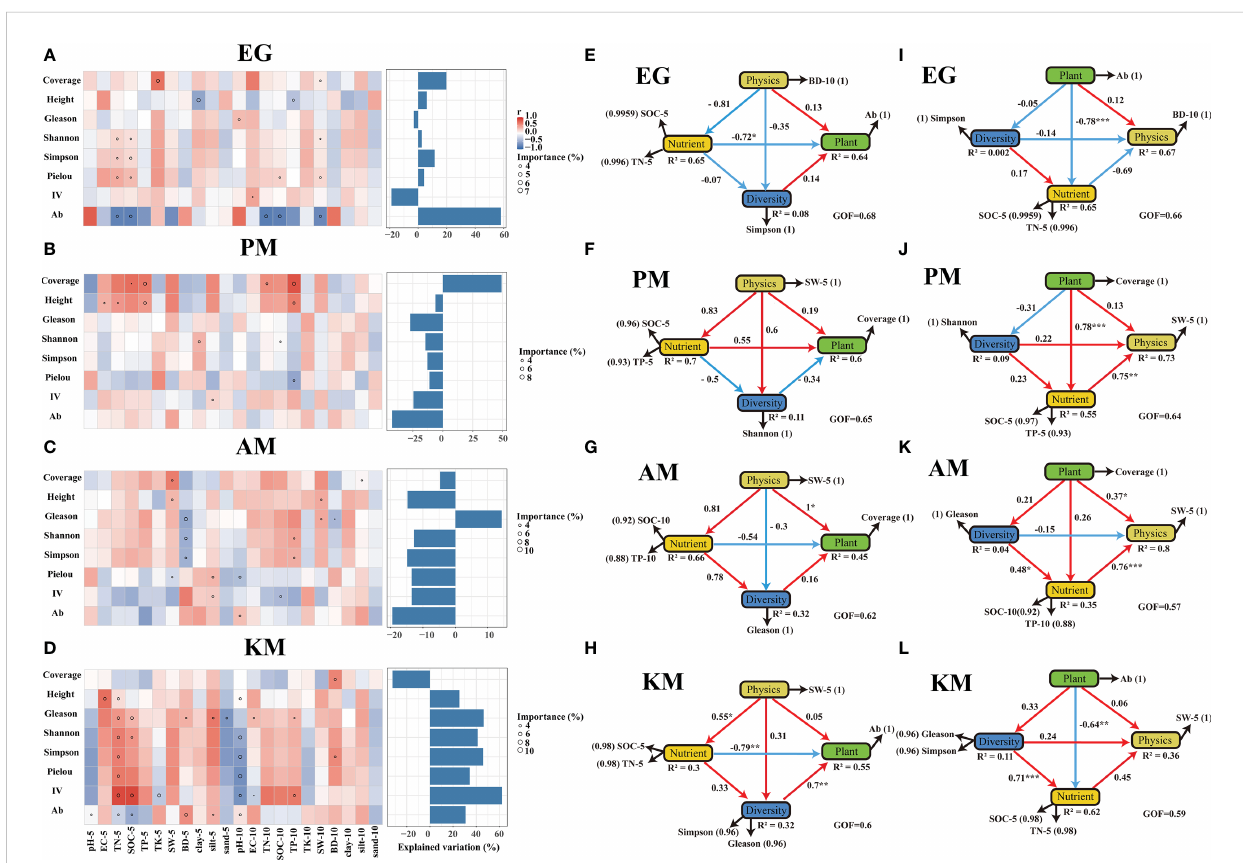
FIGURE 4 The correlations and interactions between plant communities and soil physicochemical properties. (A – D) Contributions of soil properties to the vegetation parameters based on correlation and a random forest model. The circle size represents the importance of the variables (percentage of increase of mean square error calculated via random forest model). Colors represent Spearman correlations. Diagrams (E – L) of partial least squares path models (PLS-PM) describing the interactions among the soil physicochemical properties and plant community characteristics. Each box represents a latent variable, the manifest variables are the indexes beside the latent variables, and the value in the brackets represent the loading values. Arrows connecting latent variables indicate inner model paths, with blue and red indicating negative and positive effects, respectively. R 2 denotes the proportion of variance explained. * means adjusted P values ≤ 0.05, ** means adjusted P values 175 ≤ 0.01, *** means adjusted P values ≤